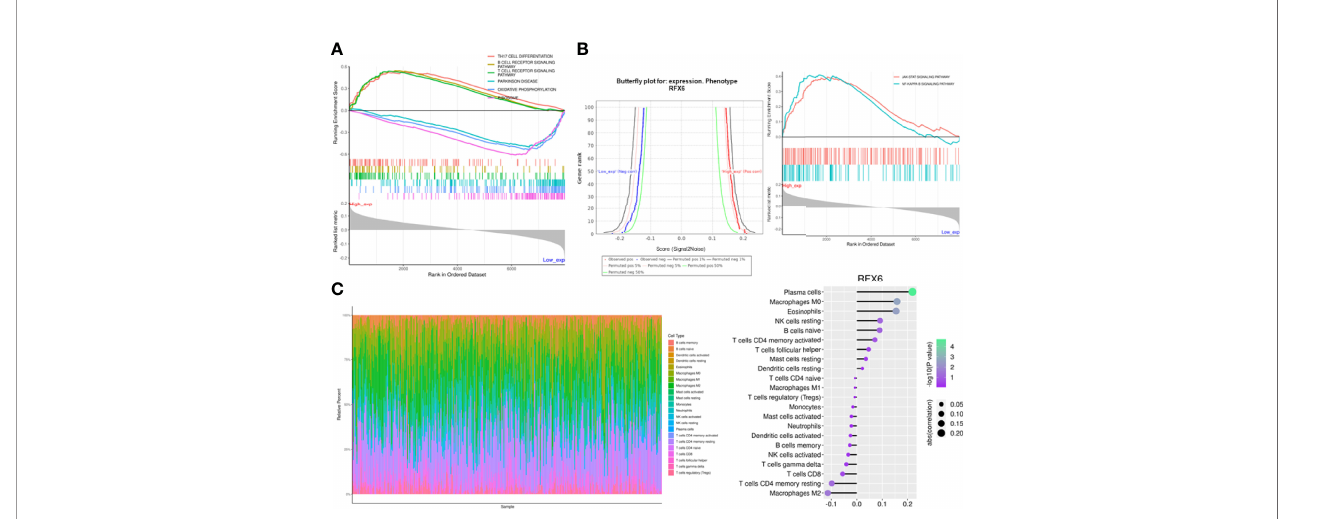
FIGURE 2 | RFX6 affects immune cell in fi ltration in the hepatocellular carcinoma microenvironment. (A) Gene set enrichment analysis of the KEGG pathways related with different RFX6 expression levels. (B) Butter fl y plot for RFX6 expression phenotype (left panel). EMT pathway enrichment according to different RFX6 expression levels (right panel). (C) CIBERSORT bar plot of different immune cell in fi ltration in the hepatocellular carcinoma microenvironment (left panel). Point plot of immune cell correlation with RFX6 (right panel).